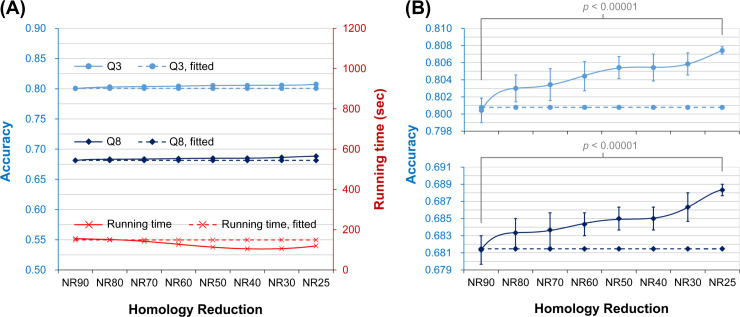
The average time cost and accuracy of the assessed secondary structure prediction methods, as the sequence homology of the target dataset reduces with a fixed dataset size.(A) The results of time cost, Q3, and Q8. (B) The results of Q3 and Q8, with the axis of accuracy zoomed in to make visible the standard deviations. In both plots, the dotted lines indicate the expected time cost or accuracy, according to the Eqs (1)–(3) formulated by target dataset size reduction. The size of these target datasets was fixed as 5 million proteins. The actual time costs (the solid red curve) by the datasets of low homology were slightly lower than the predicted, indicating that homology reduction of the target dataset can slightly improve the speed of SSP. More interestingly, the accuracies achieved by low homology sets were not only higher than the values predicted based on Eqs (2) and (3) but also significantly higher than the accuracies achieved by high homology sets. These data were averaged over seven methods. All p-values of these methods for the difference in Q3 or Q8 between the NR25 and NR90 datasets were <10−5. To conclude, homology reduction of the PSSM target dataset helps improve SSP accuracy.